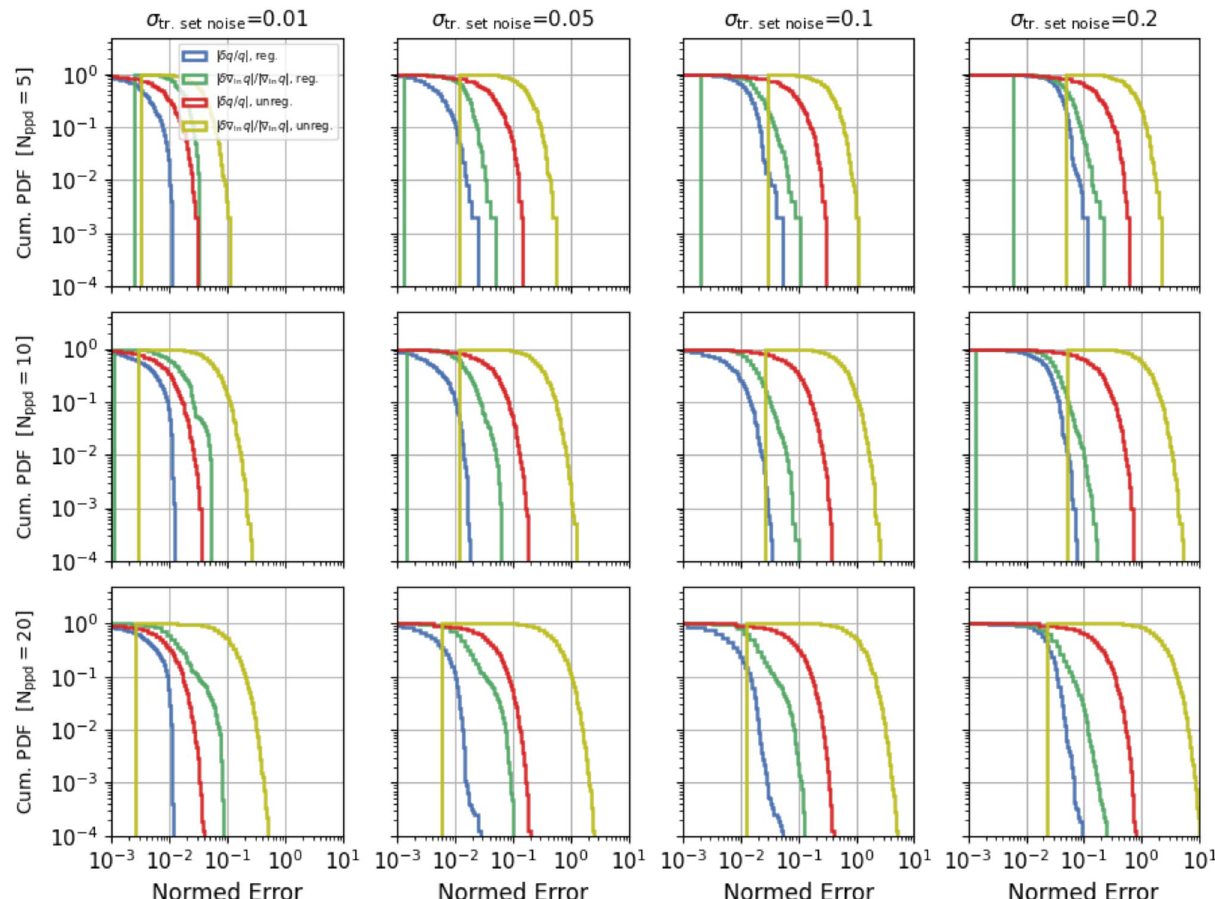
Figure 5. Regularization results: for each combination of the N ppd and σ n parameters, the blue and red curve show the cumulative distributions of the relative error of the flux function while the green and olive curves show the cumulative distributions of the flux gradient relative error, estimated by the ratio of the Euclidean norm of the flux log-gradient error and the Euclidean norm of the correct flux log-gradient (see main text for definition of log-gradient and Euclidean for the the regularised (blue and green) and unregularised (red and olive) data, respectively. To estimate the flux gradient error, we compute the Euclidean norm of the flux log-gradient error and divide it by the Euclidean norm of the correct flux log-gradient. Here log-gradient of f ( x ) , with x a vector, means that ( ) 1 / 2 . Additional statistics on the errors and their trends with the N ppd x 2 and Euclidean norm of x means ( i i (cid:31)